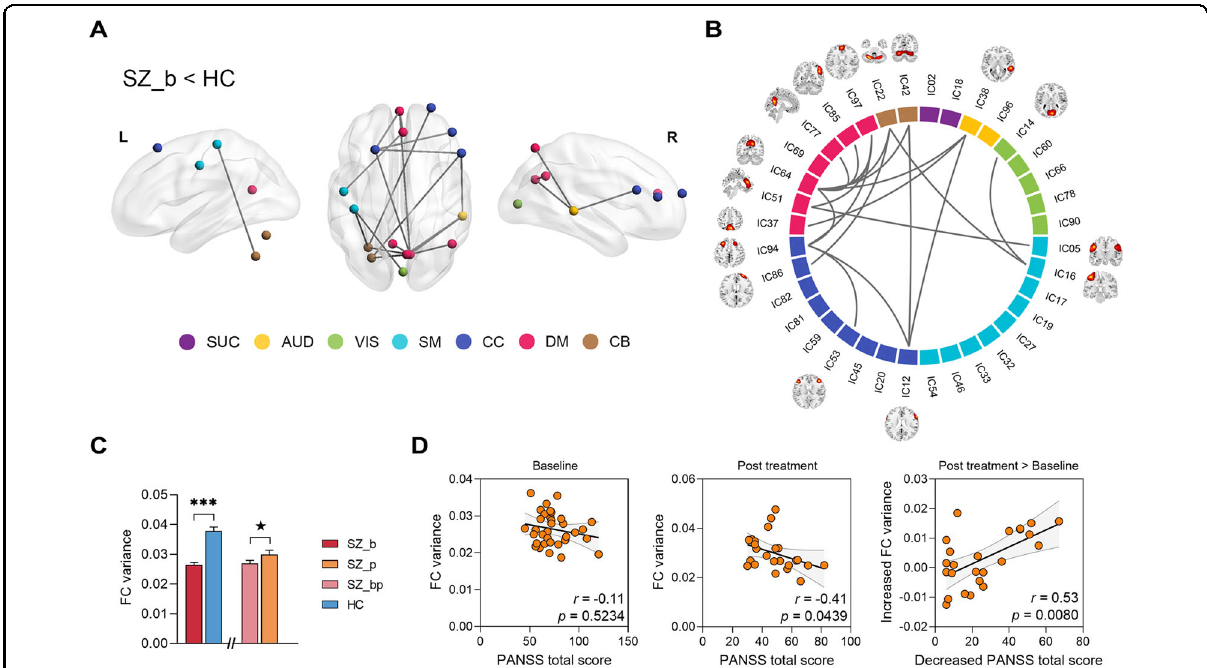
Fig. 2 The connectomic signature and association with psychosis symptoms. A , B The functional connectomic signature was identi fi ed by using the NBS at baseline (SZ_b < HC). C Group differences in FC variability of this signature. D Associations between FC variability and psychosis symptoms. *** P < 0.001, ★ P = 0.058,